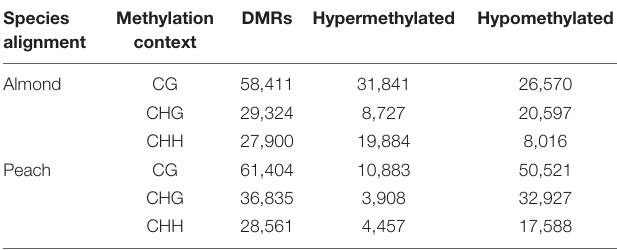
TABLE 2 | The number of differentially methylated regions (DMRs) in each methylation context [CG, CHG, CHH (H = A, T, C)] identified by comparing almond × peach hybrids with and without bud